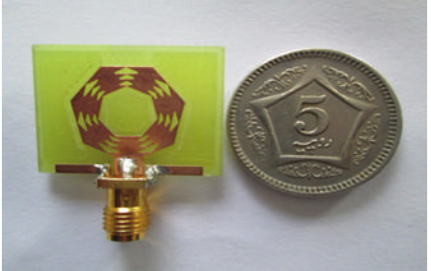
Figure 3: Fabricated prototype antenna on FR4 substrate.